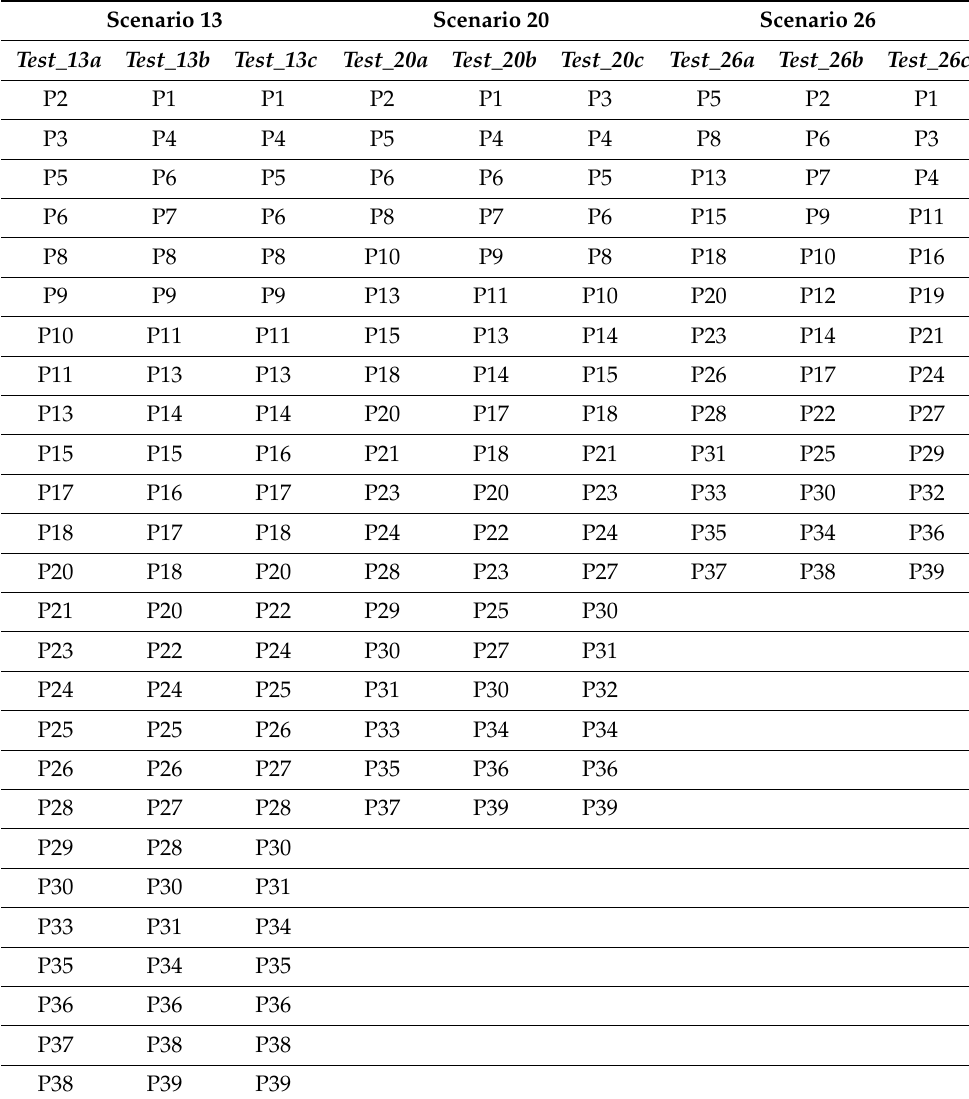
Table 1. Control (validation) sensors with respect to scenarios and